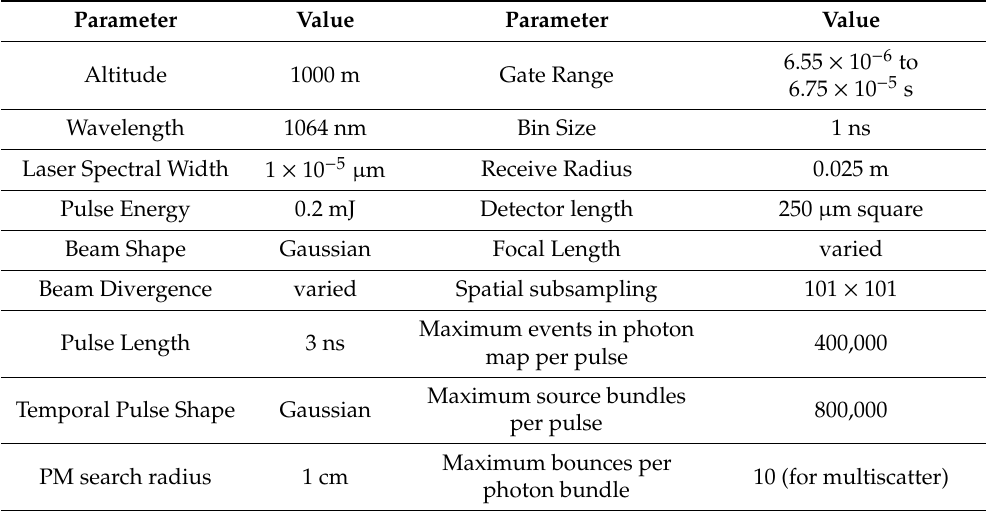
Table 2. DIRSIG lidar settings for RAMI-IV